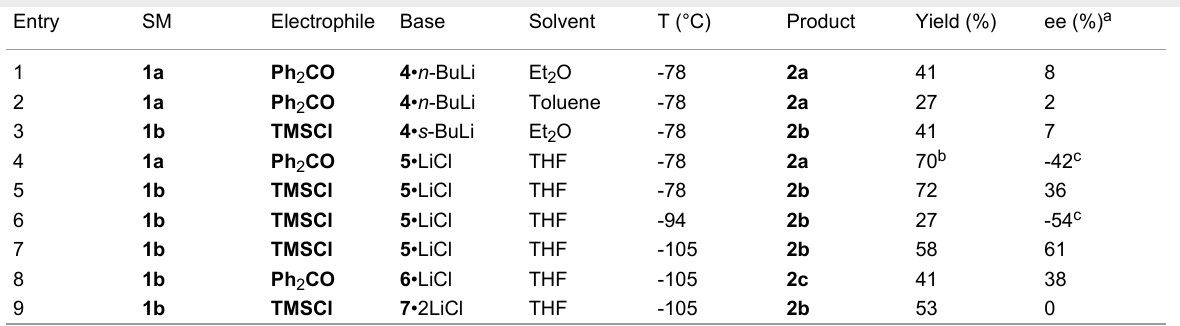
Table 1: Enantioselective Deprotonation of Trialkylsilyl-protected Sulfoximines 1: Optimisation of Reaction Conditions Entry SM